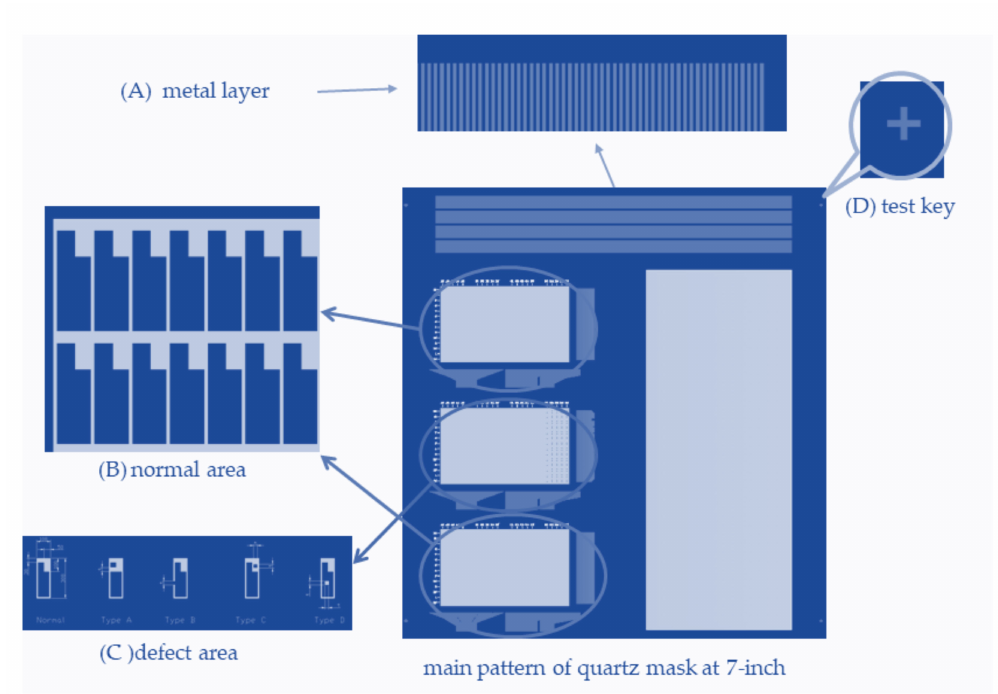
Figure 5. The right patter at ( A ) metal layer and ( D ) test key, and the left pattern at ( B ) and ( C ) of the 7-inch mask scheme for AOI